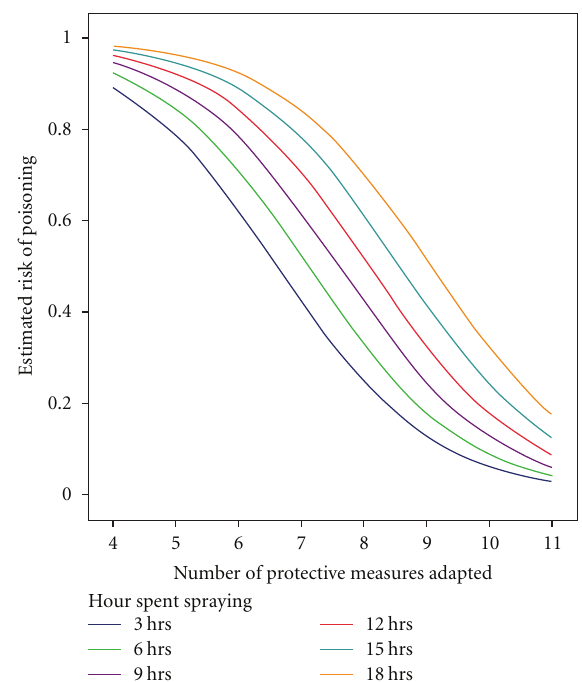
Figure 1: Estimated risk of acute pesticide poisoning for farmers of high educational